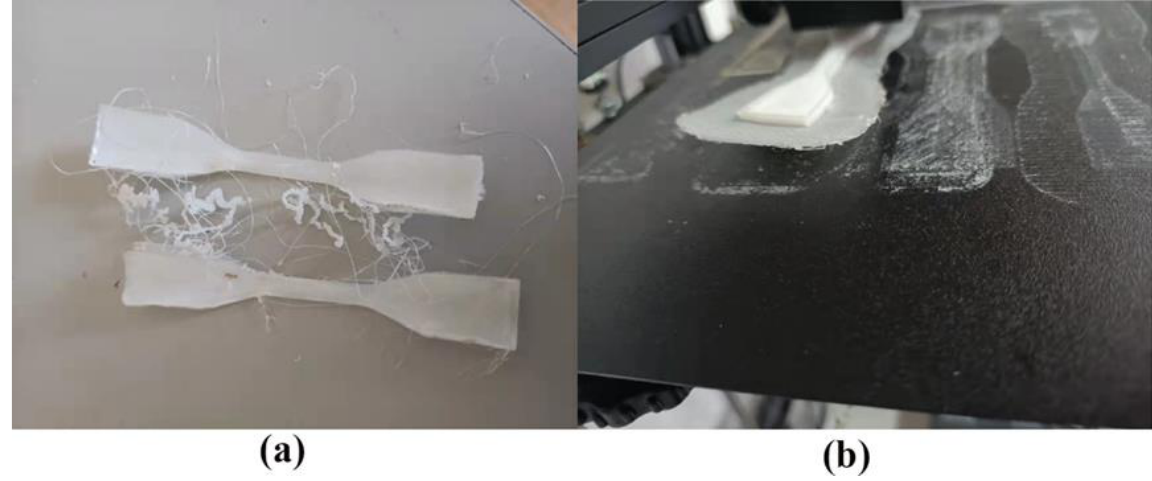
Figure 7. ( a ) Failed print while taking 7 parameters; ( b ) wrapped print at 245 °C.